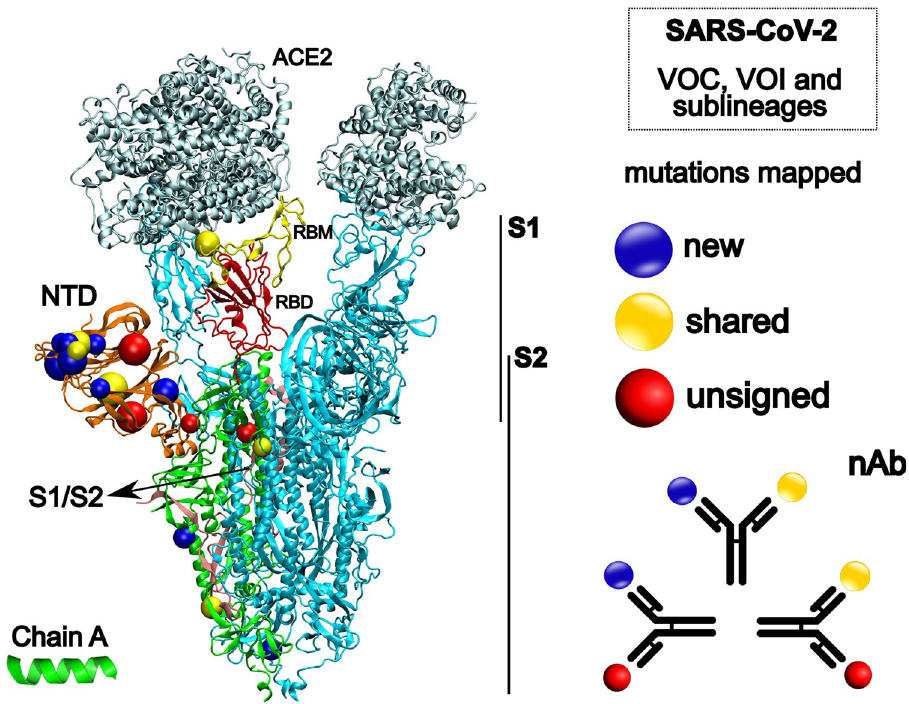
Fig 4. Structural representation of the SARS-CoV-2 spike glycoprotein (PDB 7A98). On the left side, different colors represent ACE2, angiotensin-converting enzyme 2 (silver); NTD, N-terminal domain (orange); RBM, receptor binding motif (yellow); RBD, receptor binding domain (red) and S1/S2, cleavage site to S2 (pink). The structures in blue represent the chain B and C, respectively. Colored spheres highlight the mutations mapped in the study. On the right side, our hypotheses about a linear perspective into the prospective vaccine efficacy against different SARS-CoV-2 strains. nAb, neutralizing antibody. Spike protein image was created with the Visual Molecular Dynamics